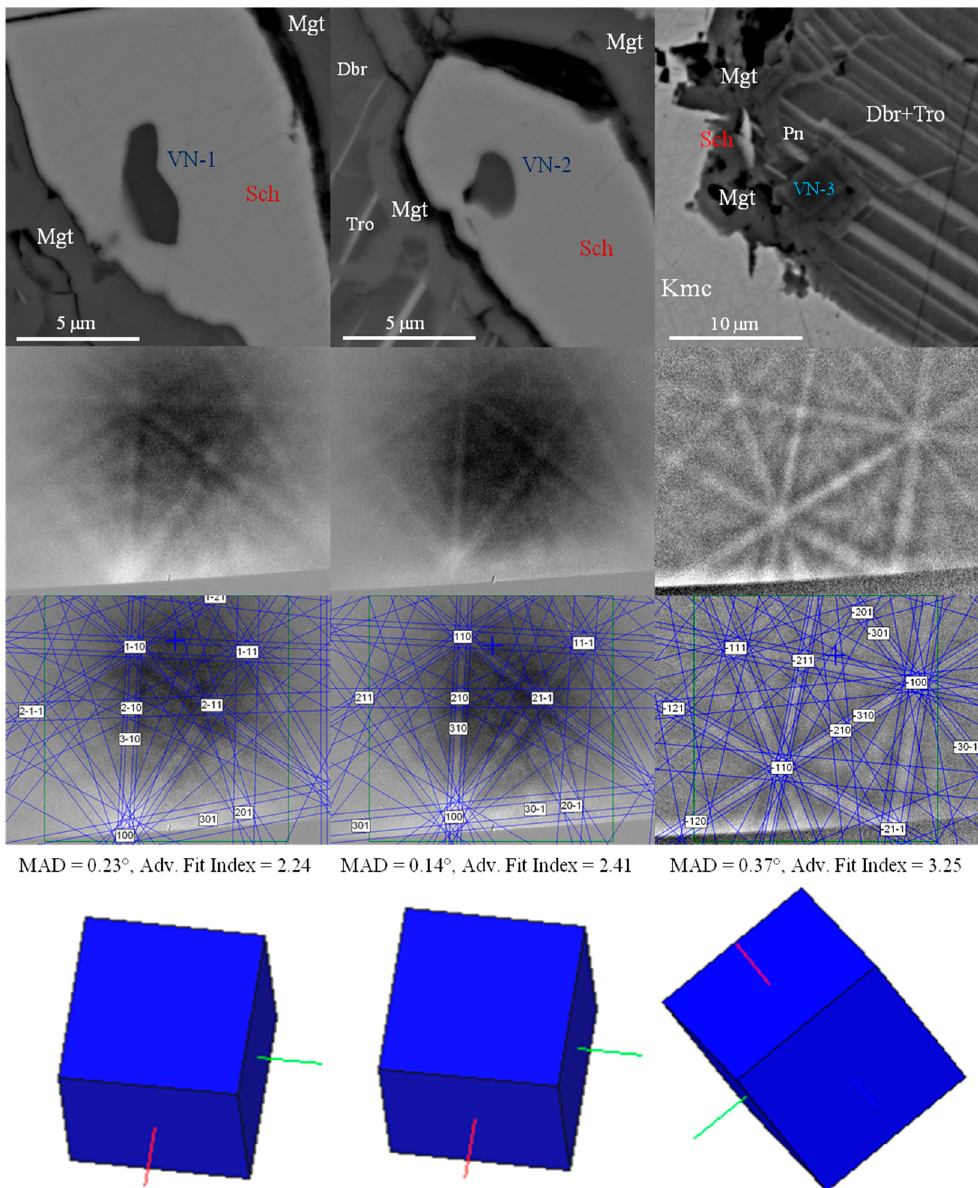
Figure 12. Electron backscattered diffraction (EBSD) patterns, the Kikuchi patterns and orientation for three grains of uakitite (detector distance: 15 – 20 mm). Symbols: VN-1 – VN-3 — uakitite (see Figure 5); Mgt — magnetite; Sch — schreibersite; Pn — pentlandite; Dbr + Tro — daubréelite + troilite; MAD — mean angular deviation.